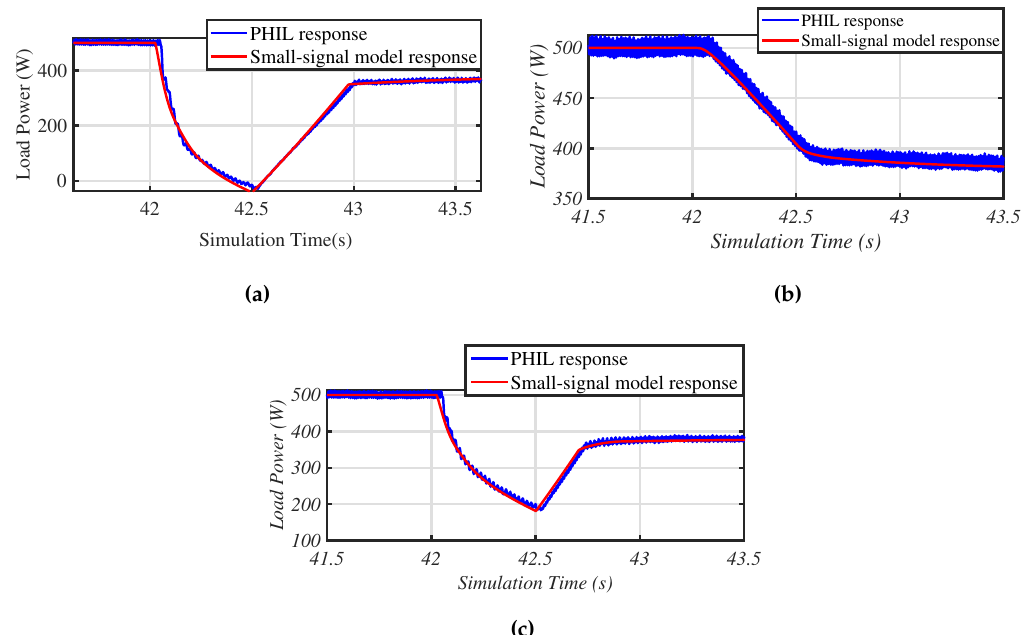
Figure 10. Comparison of the small-signal model with the hardware setup. ( a ) Case 10. ( b ) Case 11. ( c ) Case 12. PHIL, power hardware in the